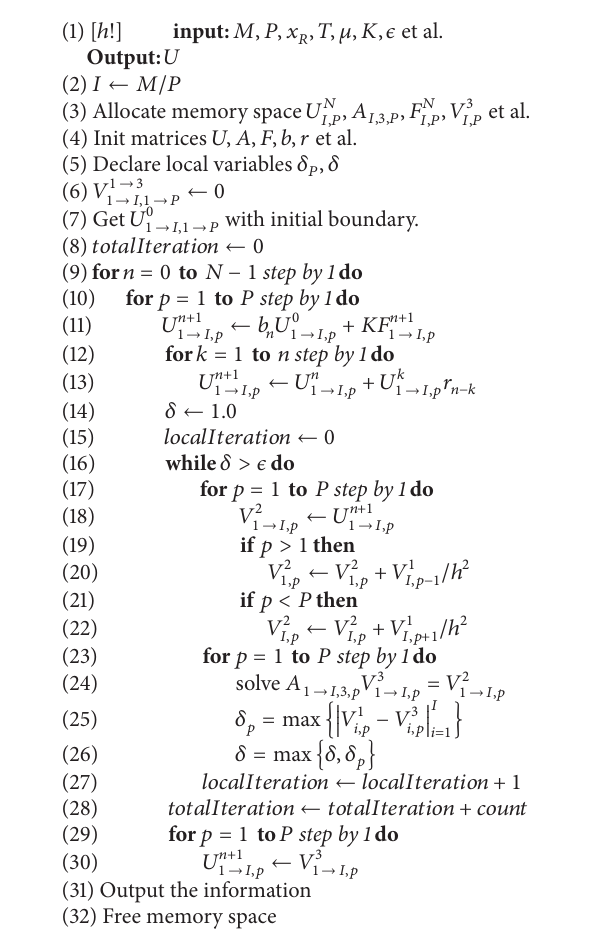
Algorithm 1: Domain decomposition algorithm for time fractional reaction-diffusion equation.